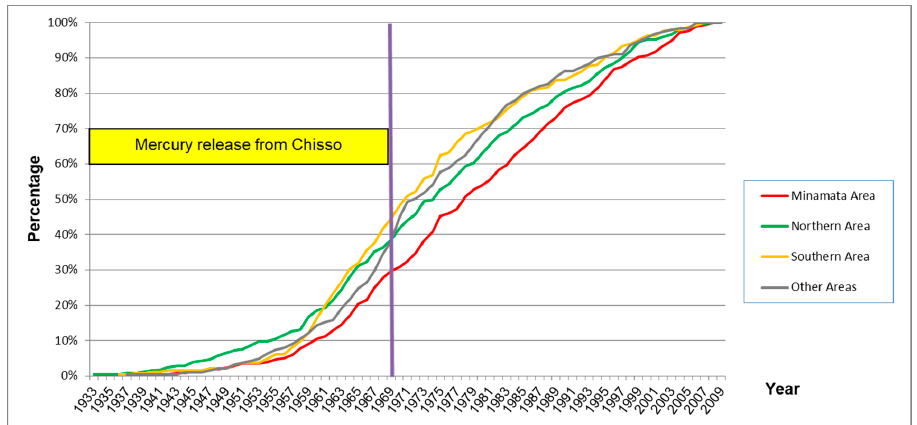
Figure 7. Onset year of each neurological symptom (actual number). Sixty-five percent of the subjects in the exposed area experienced their first symptoms after 1968, when polluted waste water from the Chisso Company’s factory was halted. Symptoms have even appeared in recent years. Toxics 2018 , 6 , x FOR PEER REVIEW The appearance of symptoms was almost the same among the four exposed groups. Figure 8 shows the cumulative rate of onset year of the first symptom in each exposed group.